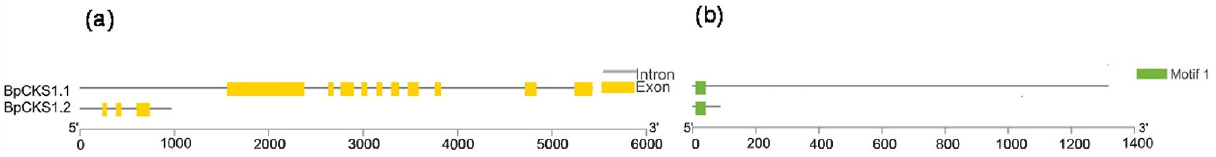
Figure 4. Exon/Intron genomic structure and protein motif organization of CKS in B. pendula . Gene structure of the corresponding BpCKSs genes, TBtools software was used to visualize gene structure. The yellow boxes represent exons and grey lines represent introns. Use MEME web server to analyze the distribution of conserved motifs in BpCKSs protein. The protein motif figure of BpCKSs was constructed by TBtools software. ( a ) Exon/intron genomic structure of BpCKSs ; ( b ) protein motif organization of BpCKSs.